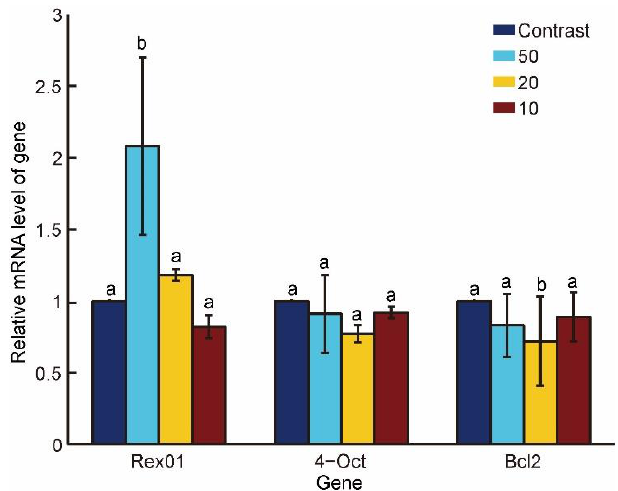
Figure 8. Gene expressions of the embryos at 17 h after oocytes been fused/activated. The Rex01 gene expression at the penetration speed of 50 μm /s was significantly higher than those of control, 20 μm /s and 10 μm /s ( p < 0.05). The a and b in the figure mean the data in b group is significantly different from that of a.